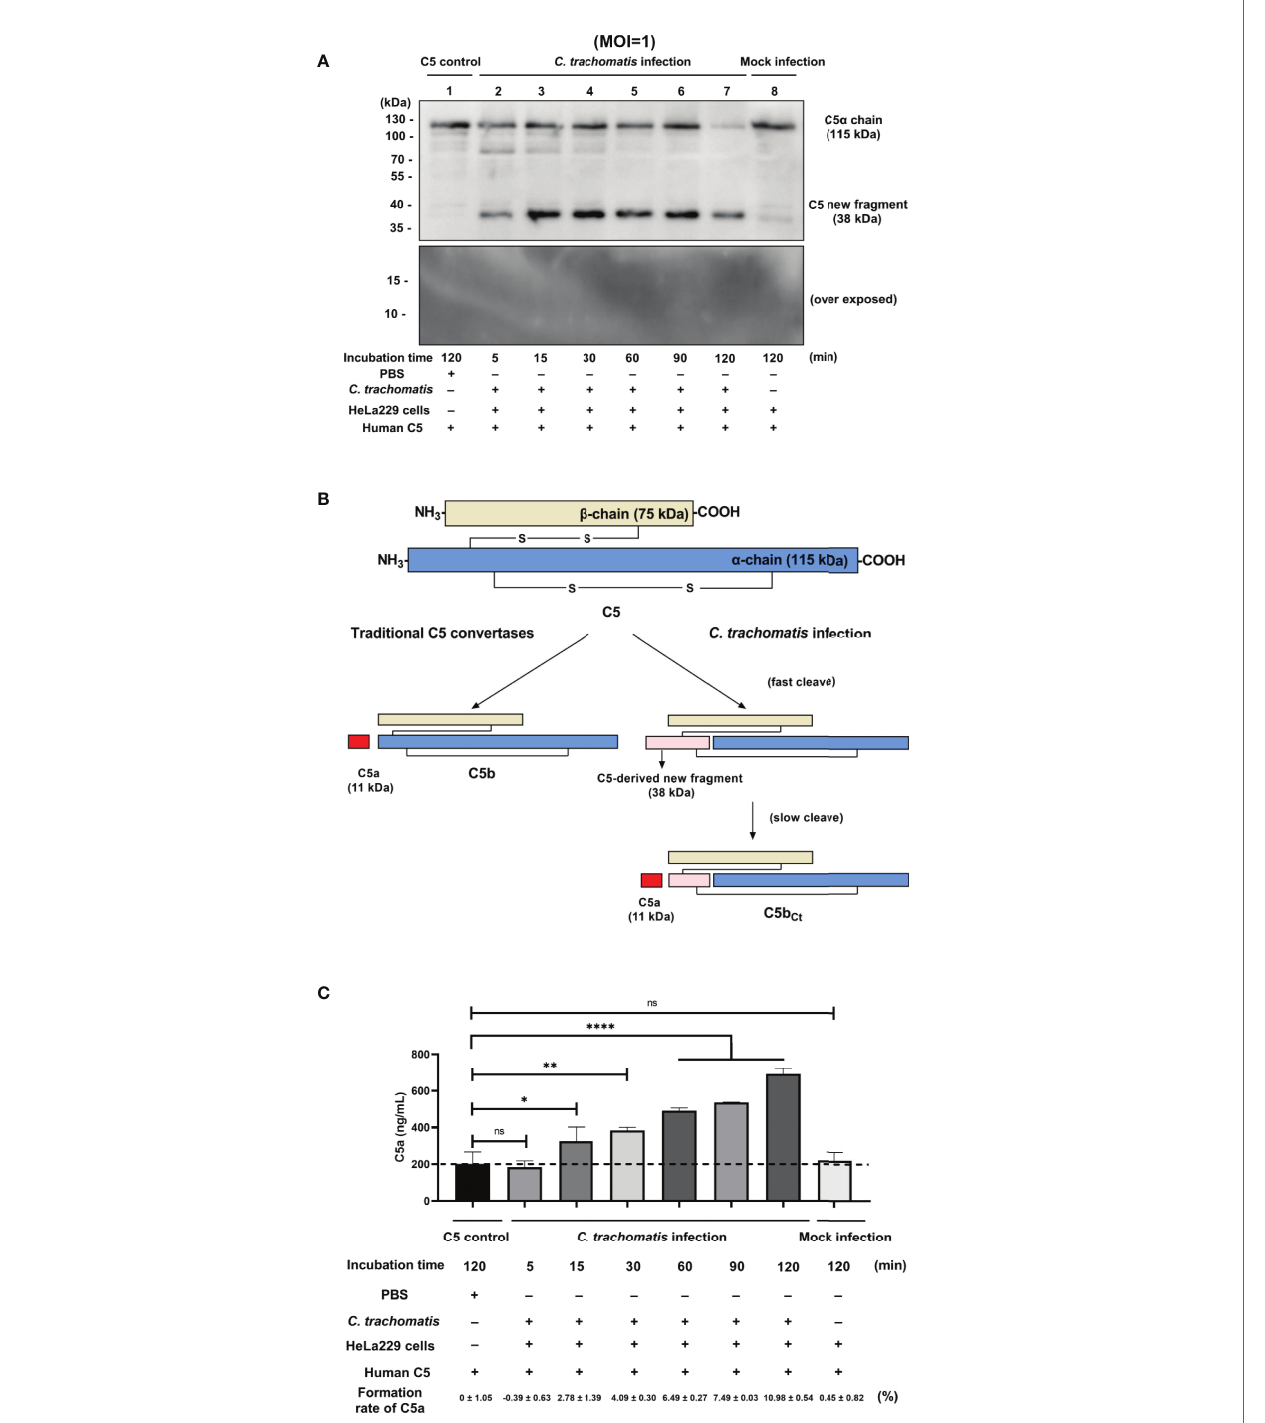
FIGURE 1 | C. trachomatis infection yielded a novel undescribed C5 fragment independent of C3. (A) C . trachomatis -HeLa229 cell lysates (MOI=1) incubated with human puri fi ed C5 (400 nM) produced a previously undescribed ~38-kDa fragment encompassing C5a in Western blot analysis. (B) Schematic overview of proteolytical processing of C5 induced by traditional C5 convertases or C . trachomatis infection. (C) C . trachomatis infection generated a limited amount of C5a in the absence of C3 detected by ELISA. The C5 control group was taken as the baseline. Formation rates of C5a were calculated according to the concentration of human C5 protein before the reaction (400 nM). ns, not signi fi cant; *P < 0.05; **P < 0.01; ****P < 0.0001 (Dunnett ’ s multiple comparisons test, n